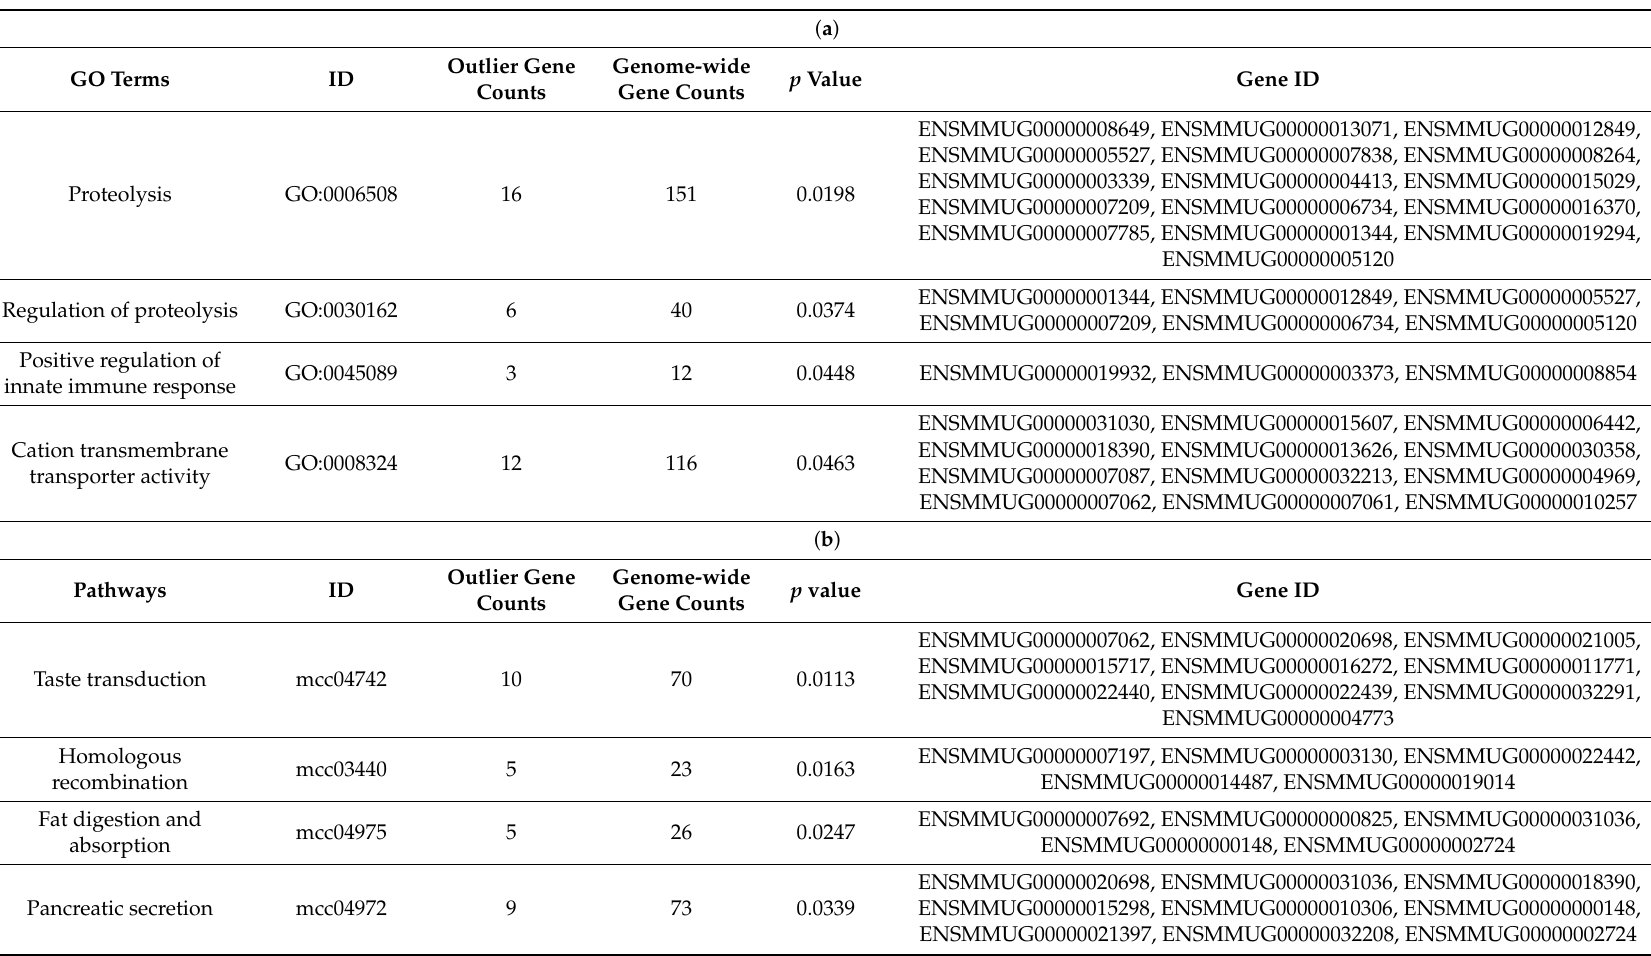
Table 4. Enrichment outputs of genes with nonsynonymous SNVs in windows with distinct nonsynonymous SNV distribution patterns based on outlier test in R, ( a ) GO term enrichment, ( b ) KEGG pathway